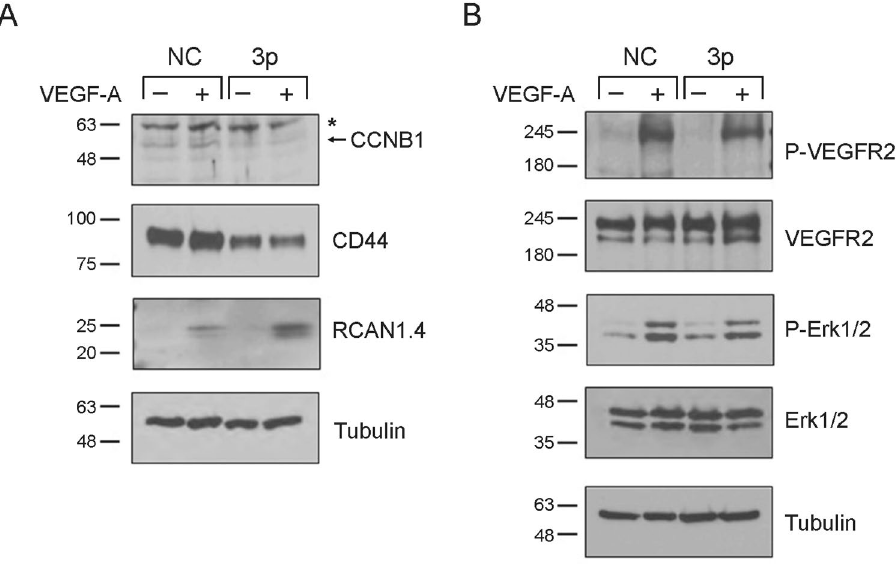
Figure 7. Ectopic expression of miR-133a-3p results in a decrease of pro-angiogenic and an increase in anti- angiogenic proteins in endothelial cells. ( A ) HUVEC were transfected with a control miR mimic (NC) or a mimic for human miR-133a-3p (3p) and were left unstimulated (−) or were stimulated with VEGF-A 165 (50 ng/ ml) for 4 h (+). Expression of CCNB1, CD44 and RCAN1.4 was determined by western blot analyses of total proteins isolated from the transfected cells. Levels of Tubulin were determined in the same samples for loading control. Blot images are representative of two independent experiments. The band corresponding to Cyclin B1 is pointed out by an arrow. *, denotes unspecific binding. ( B ) HUVEC were transfected as in ( A ) and then stimulated (+) or not (−) with VEGF-A 165 (50 ng/ml) for 5 min. The expression and phosphorylation/activation status of VEGFR2 and Erk1/2 proteins was determined by western blot analysis of total proteins isolated from the transfected cells. Blot images are representative of two independent experiments. Levels of Tubulin were determined in the same samples for loading